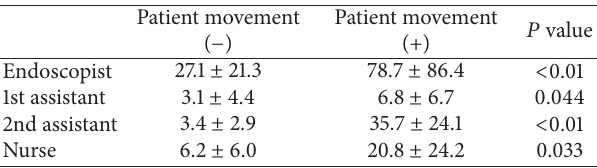
Table 4: Occupational radiation dose to each medical staff member with or without patient movement (with the use of protective cur- tains) ( 𝜇